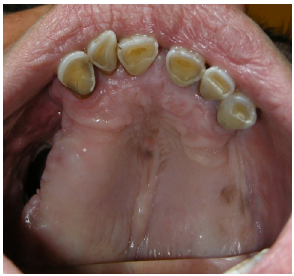
Figure 13. Patient condition at the first visit.